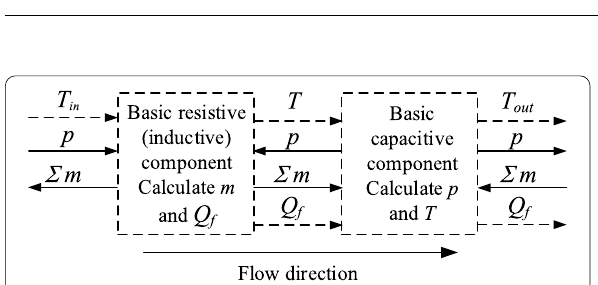
Figure 23 Connection rules of hydraulic component models